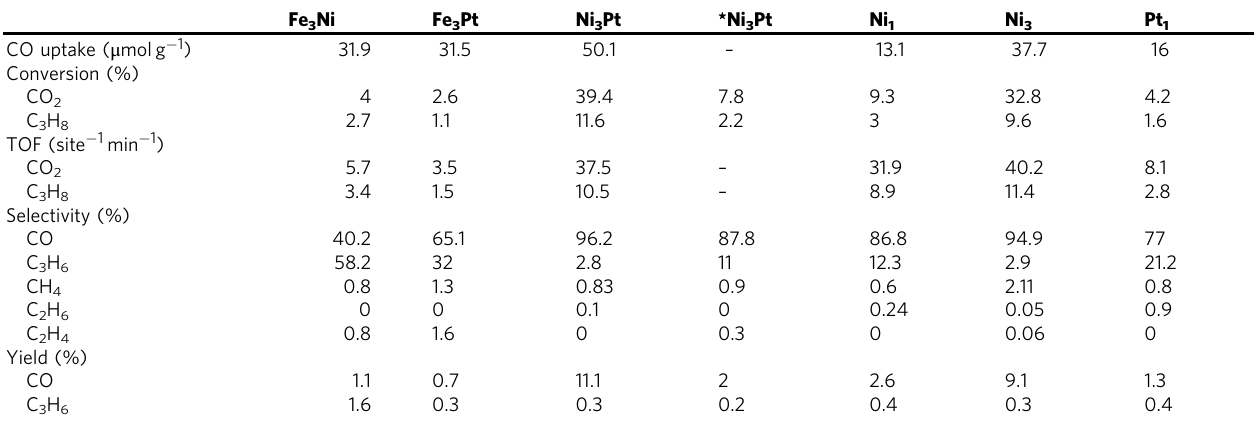
Table 1 Catalyst fl ow reactor results for CO 2 + C 3 H 8 reaction Fe 3